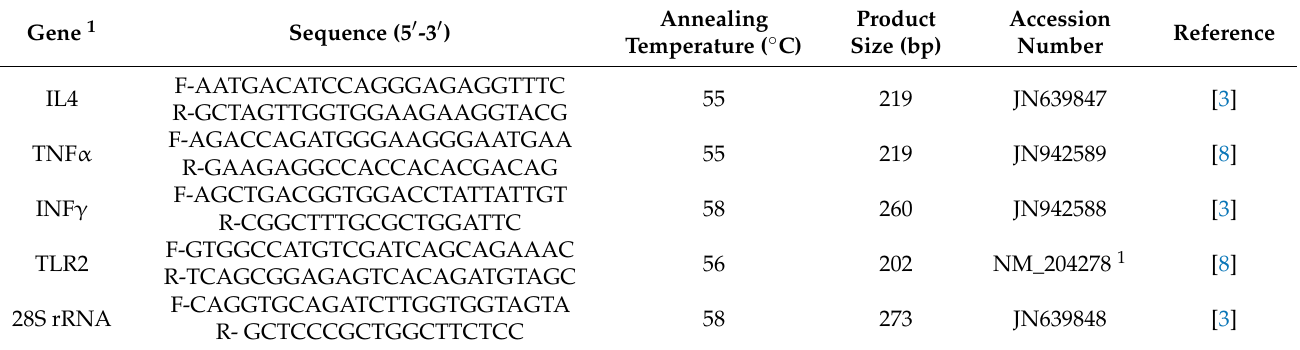
Table 1. Oligonucleotide sequence of splenic gene